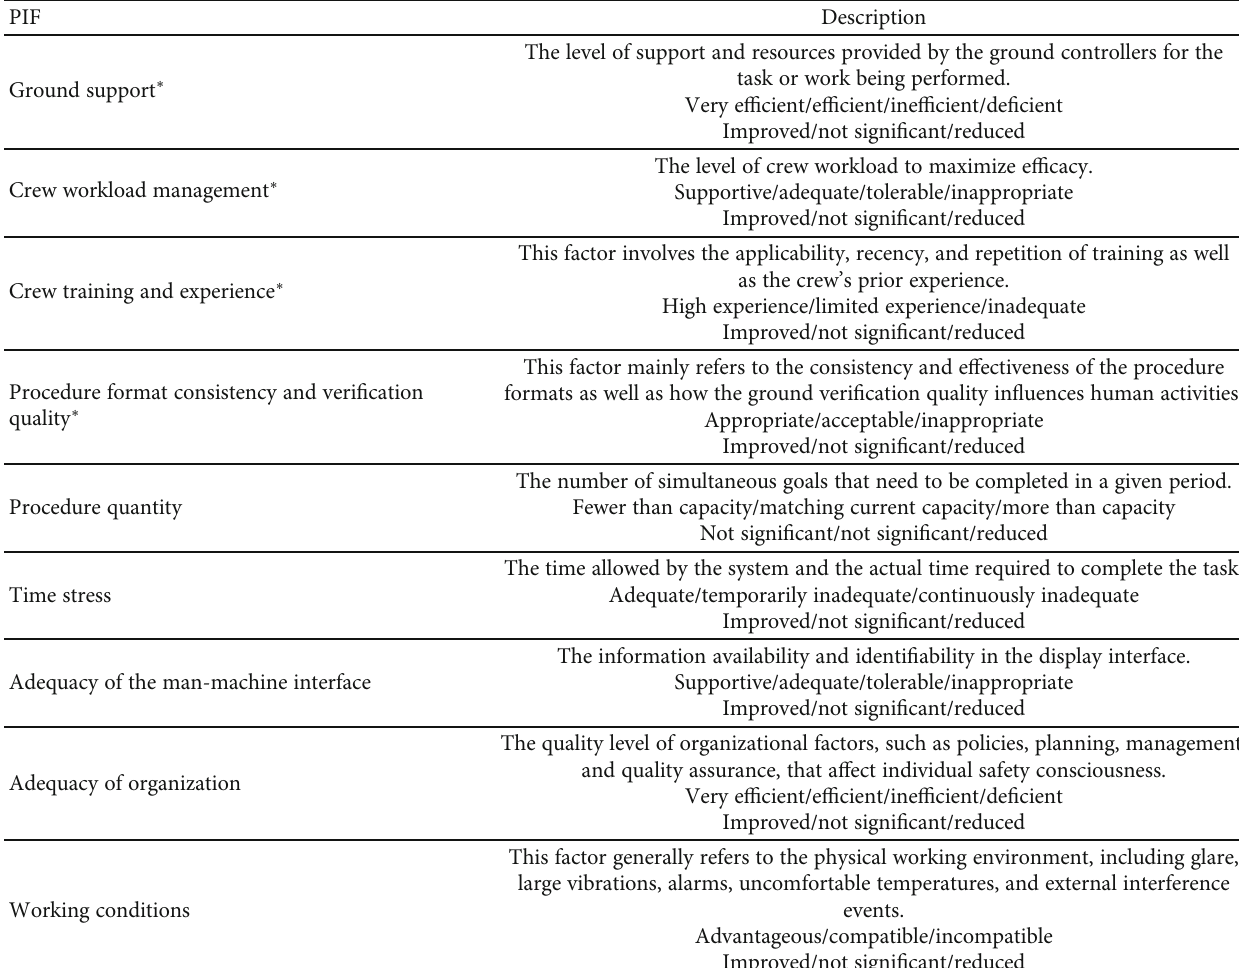
Table 1: Modi fi ed PIFs for fl